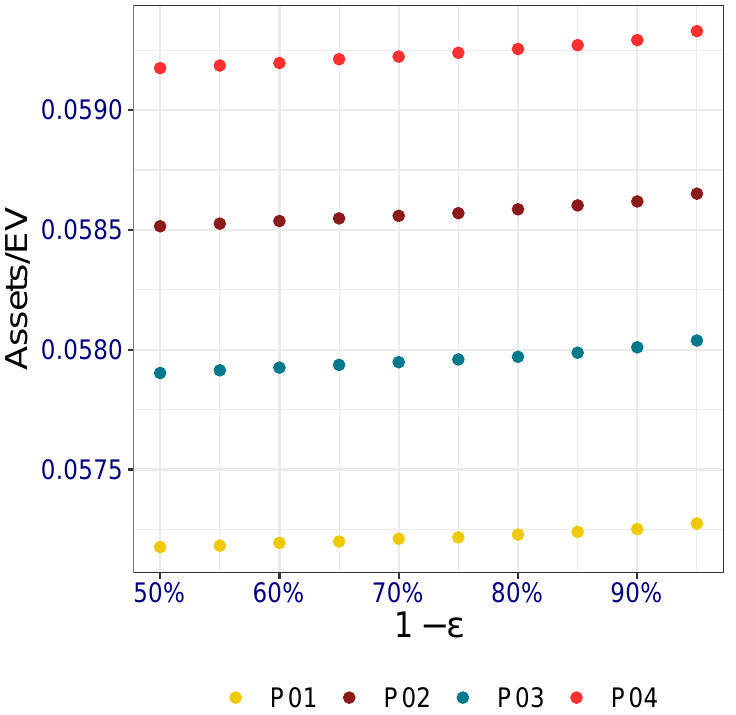
Figure 10. Impact of the portfolio structure on assets requirements at time t =